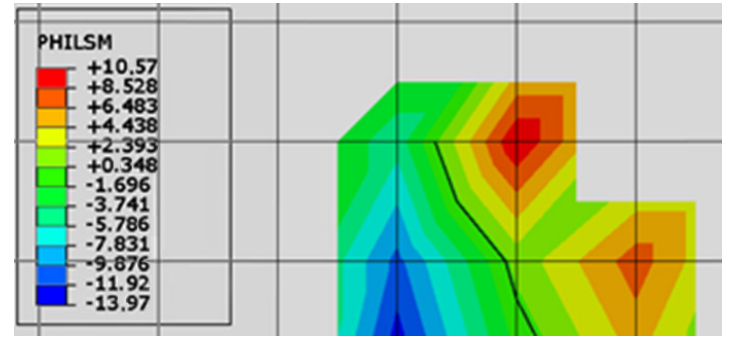
Figure 4. Explanation of the values of φ function of the level set method (PHILSM).